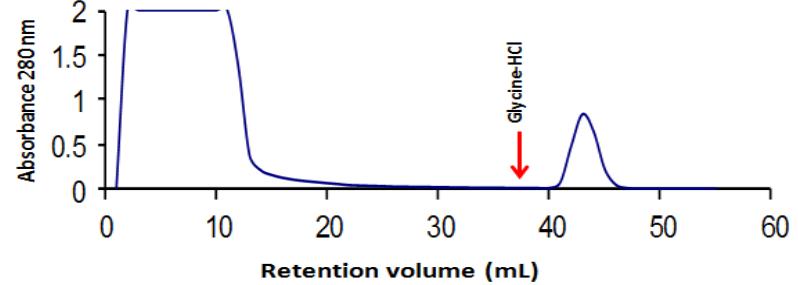
Figure 1. Affinity chromatography in immobilized fetuin of the aqueous extract from tepary beans after precipitation with ammonium sulfate. The lectin fraction was eluted with an acid solution (50 mM glycine-HCl, pH